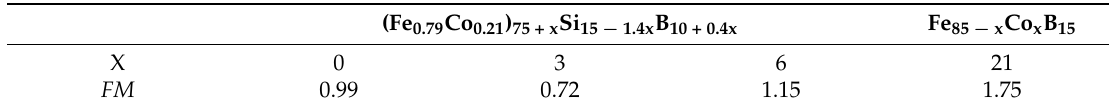
Table 3. Value of the figure of merit of each used magnetostrictive ribbon (L = 3 cm) composition, in as quenched state.